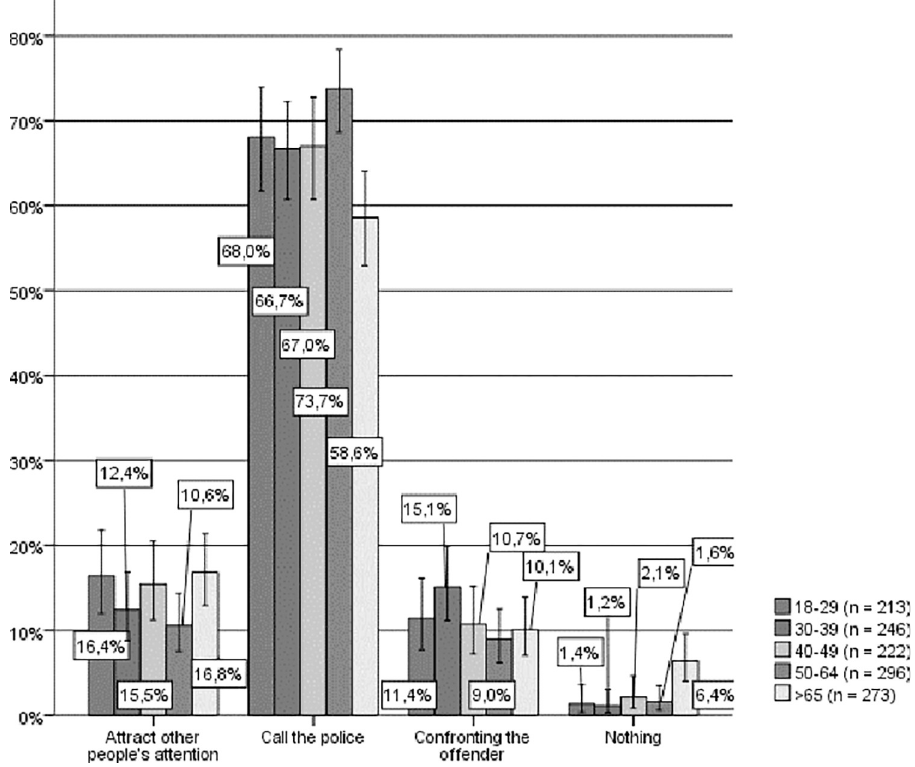
Fig 5. Hypothetical response to IPVAW, women by age group. Source: Own elaboration based on CIS study 2968 [43] question 14. 95% confidence intervals are provided for each subsample.